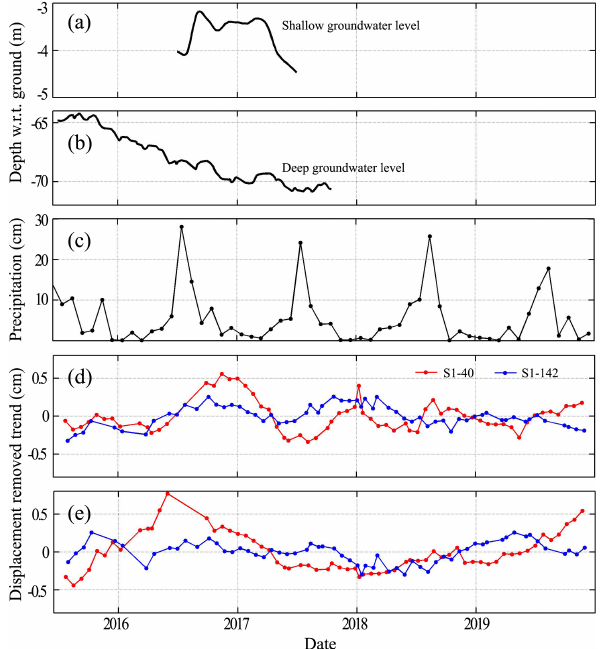
Figure 7. (a) Shallow and (b) deep ground level with respect to the ground. (c) Monthly precipitation for the Heze region during July 2015 and December 2019. After removing the linear trend, the average of residual time-series displacement of (d) R1–R7 in rural areas and (e) U1–U4 in urban